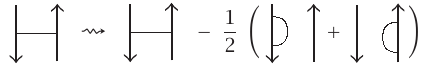
Figure A.4 . The deframing map ι